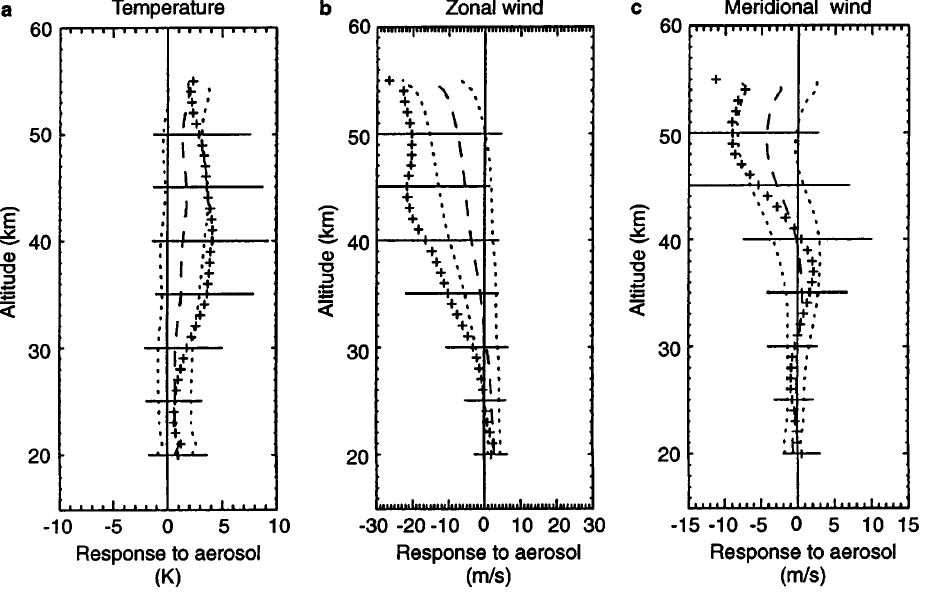
Fig. 2a–c. Vertical response in a temperature, b zonal wind and c meridional wind series (in K and in ms ) 1 ) to a mean optical depth change of 0.1, induced by stratospheric aerosols. Dashed lines are the analyses of all the data, while dotted lines are the 2 r confidence intervals. Results for winter month (December-Janu- ary-February) analyses are shown by crosses . Horizontal lines are associated with